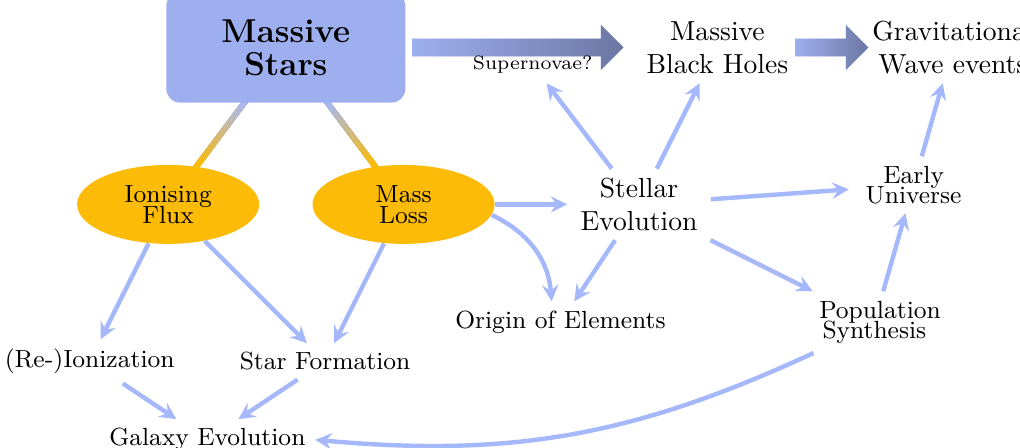
Figure 2. Overview of how massive stars, and in particular the mass-loss rates and ionising fluxes, determined in the UV, impact many adjacent areas of Astrophysics. Image credit: Andreas